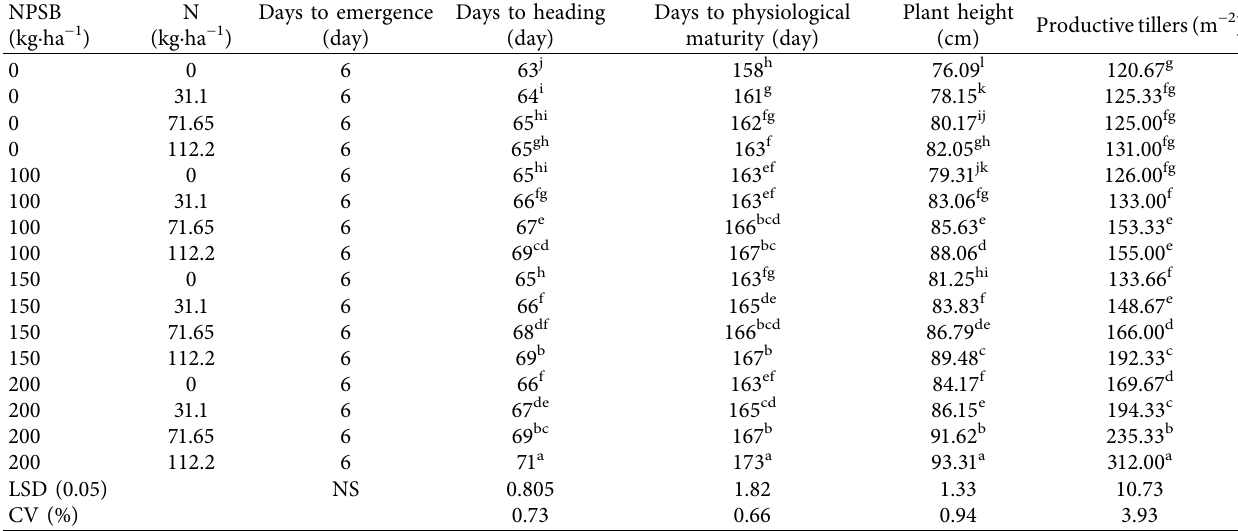
Table 3: Wheat phenology and growth characteristics are influenced by the relationship between NPSB and nitrogen levels. NPSB